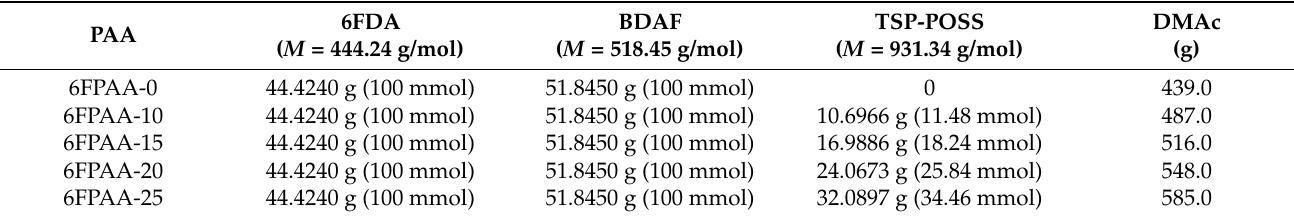
Table 1. Formulas for the synthesis of 6FPAA-X